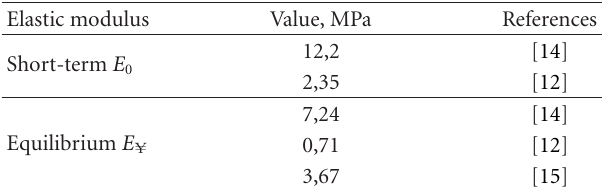
Table 1: Young’s modulus values for joint cartilage under stretch-